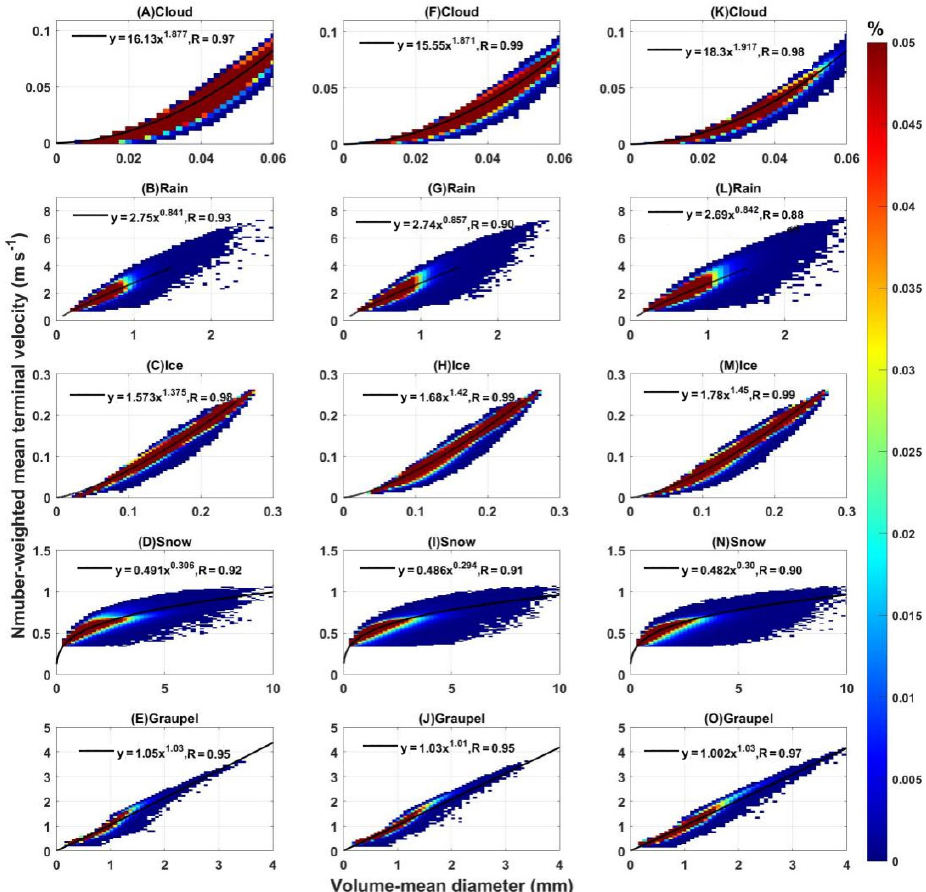
Figure 3. Joint probability density function of the relationship between number-weighted mean terminal velocity (m s − 1 ) and volume-mean diameter (mm) based on clean (left), moderate pollution (middle), and polluted (right) conditions for different types of hydrometeors: ( A , F , K ), cloud droplets, ( B , G , L ) raindrops, ( C , H , M ) ice crystals, ( D , I , N ) snow, and ( E , J , O ) graupel particles. The black curves indicate the fitting function, and R represents the correlation coefficient. In the fitting function, x and y represent the volume-mean diameter and the number-weighted mean terminal velocity,